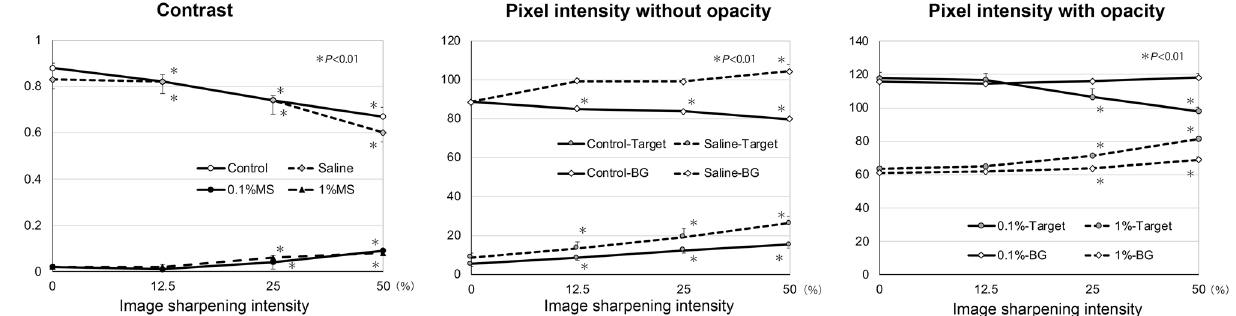
Figure 7. The contrast and the pixel intensity of the images of the grating target. The contrast decreases significantly with an increase of image-sharpening intensity in the control (no fluid) and in saline. On the other hand, the contrast increases significantly with the increase of image-sharpening intensity in 0.1% milk solution (MS) and 1% MS at the intensity of 25% and 50%. The pixel intensity of the grating targets images increases significantly with the increase of image-sharpening intensity in the control and saline. The pixel intensity of the background (BG) between the grating targets images decreases significantly with the increase of image- sharpening intensity in the control. In contrast, the pixel intensity of the BG gradually increases with the increase of image-sharpening intensity in the saline and increases significantly at the image-sharpening intensity of